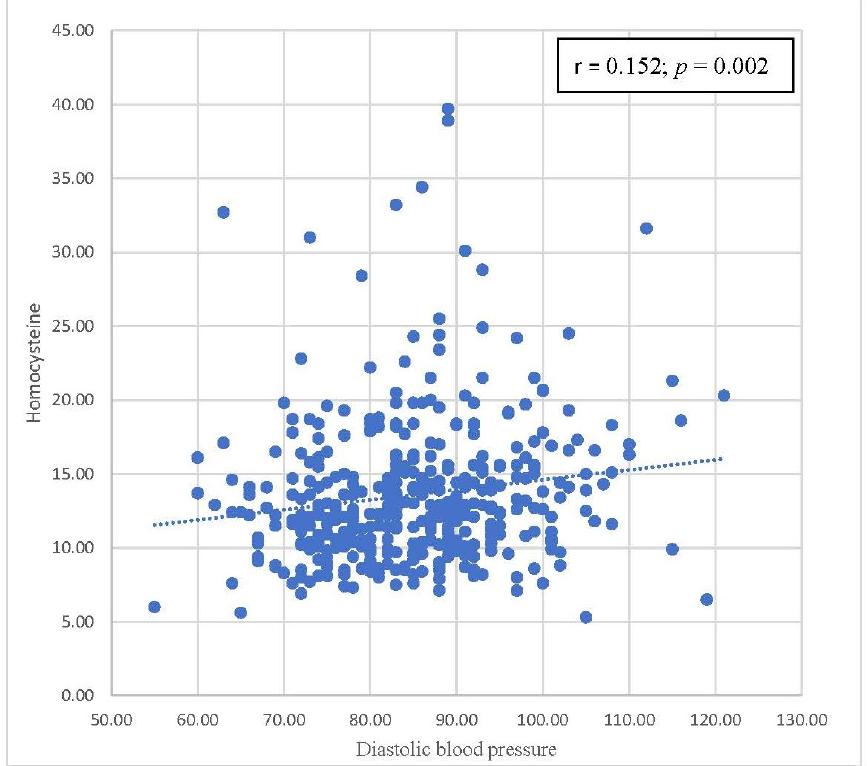
Figure 3. Scatterplot with the fit line of homocysteine levels by systolic blood pressure.